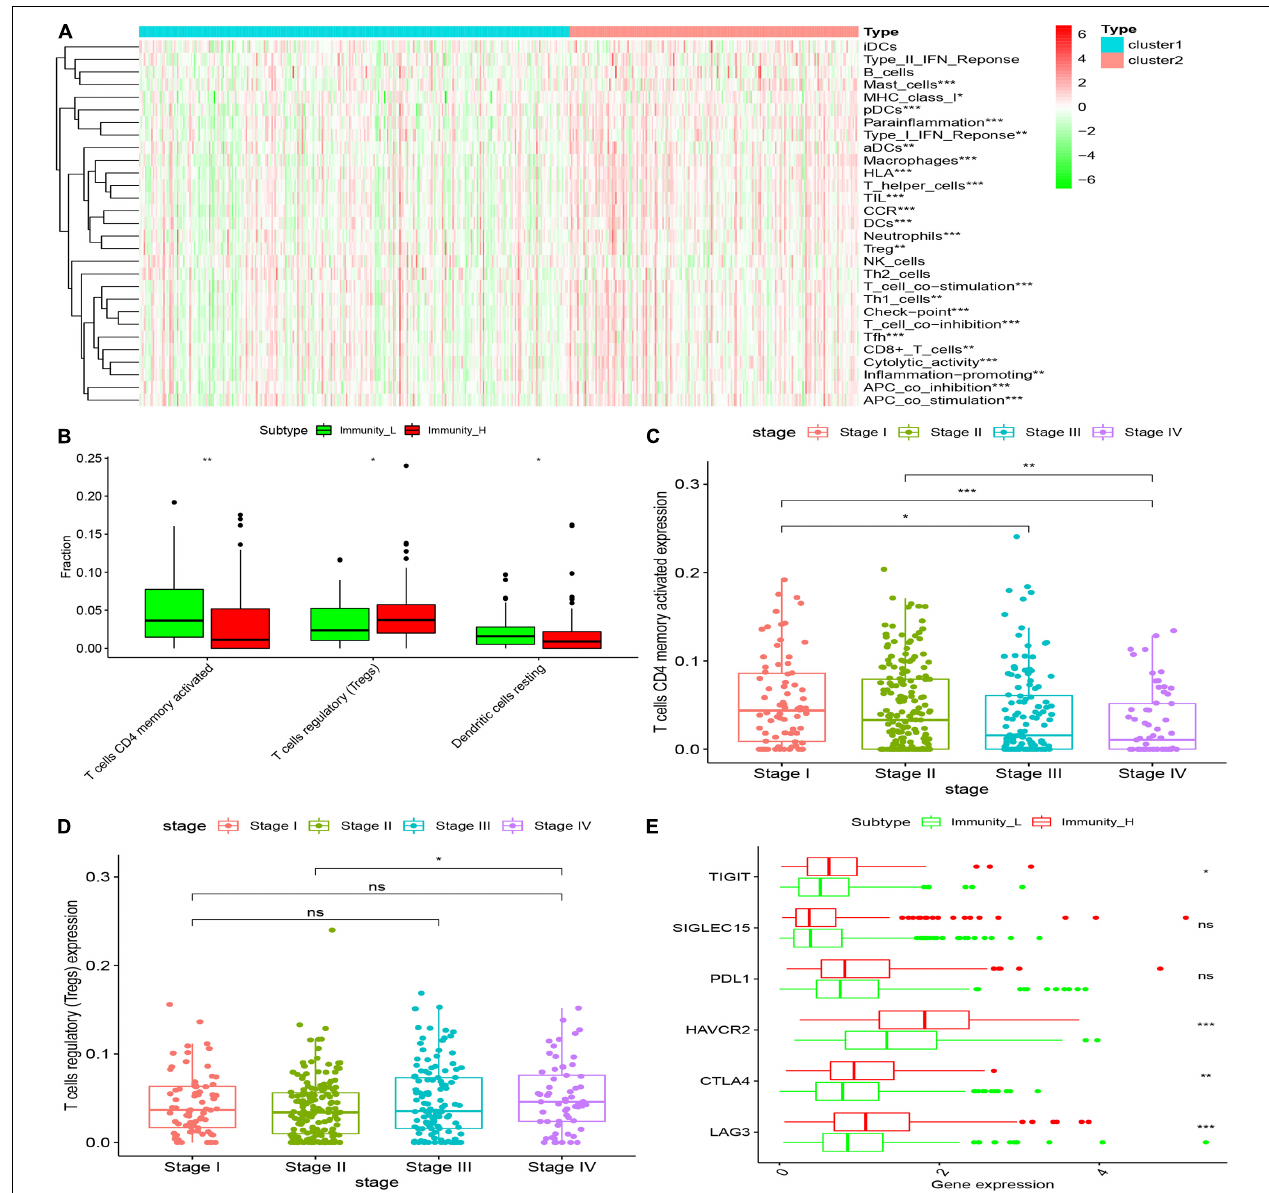
FIGURE 4 | The immune components of different clusters were evaluated. (A) The results of SSGSEA showed that the low expression of CD34 and CD276 in the Cluster1 group was the low immune score group, while the high expression of CD34 and CD276 in the Cluster2 group was the high immune score group (* P < 0.05, ** P < 0.01, *** P < 0.001). (B) The immune cell composition of Cluster1 and Cluster2 was further analyzed using the Ciborsort R package. The results showed that in Cluster2, the ratio of activated memory T cellsCD4 and dendritic resting cells was lower than that in Cluster1 (* P < 0.05, ** P < 0.01), while the ratio of regulatory T cells was relatively higher in Cluster1 (* P < 0.05, ** P < 0.01, *** P < 0.001). (C,D) The infiltration level of activated memory T cellsCD4 was negatively correlated with CRC TNM stage, the infiltration level of T cells (Tregs) was positively correlated with tumor TNM stage (* P < 0.05). (E) There was no significant difference in the expression of immune checkpoint PDL1 and SiGLEC15 between the groups with high and low immune scores ( P > 0.05); the expression levels of TIGIT and CTLA4 were up-regulated in the group with high immune scores, and the expression levels of HAVCR2 and LAG3 were significantly up-regulated in the group with high immune scores (* P < 0.05, ** P < 0.01, *** P <